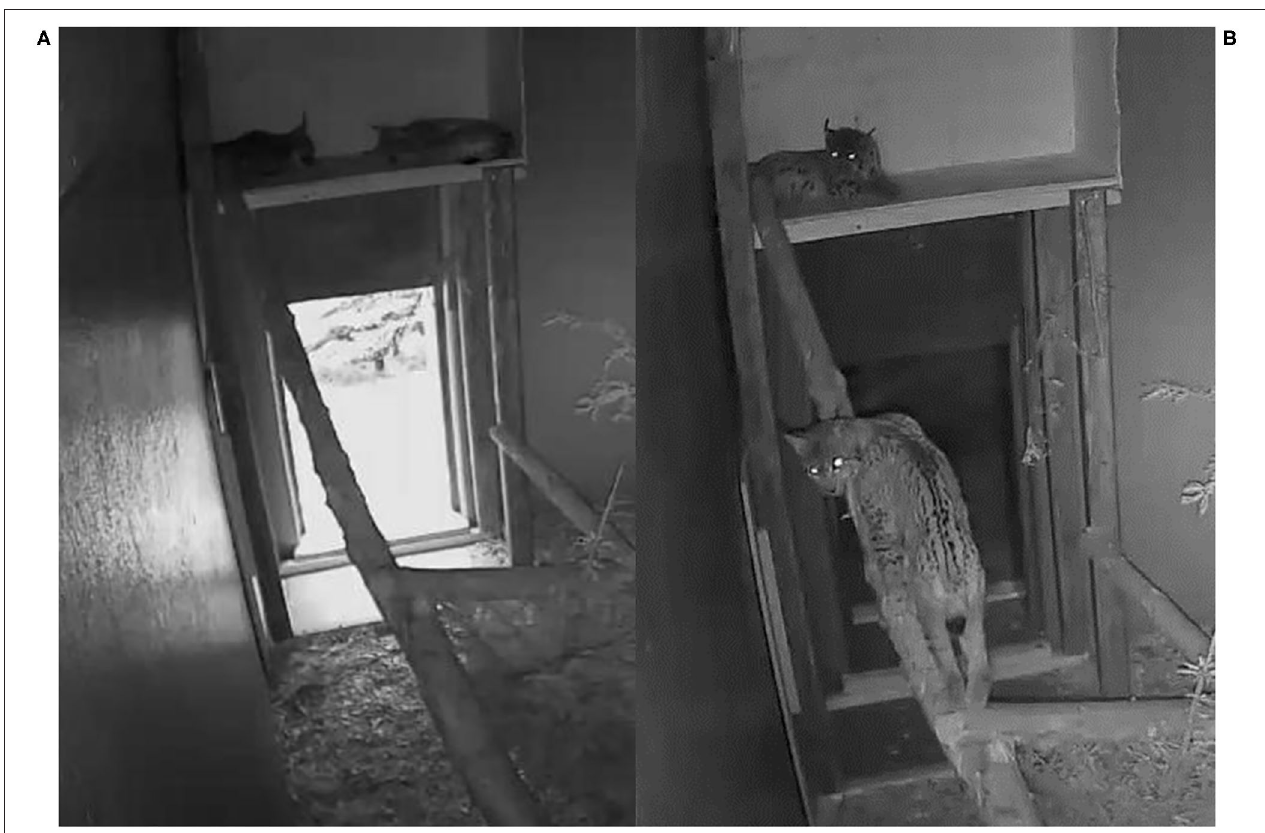
FIGURE 6 | Behavior during quarantine as captured by video-monitoring, Eurasian lynx ( Lynx lynx ), NAIA and SENI; (A) Lethargy during daytime; (B) Moderate activity at night, SENI on the tree trunk in poor body